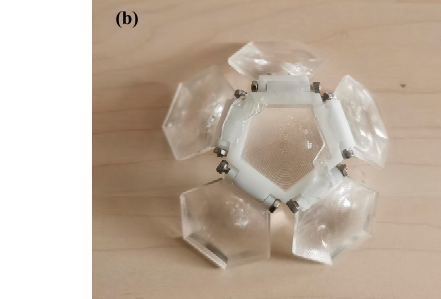
Figure 2. Schematic diagram of the dynamic UOWC system. ( a ) With one lens; ( b ) With lens array.